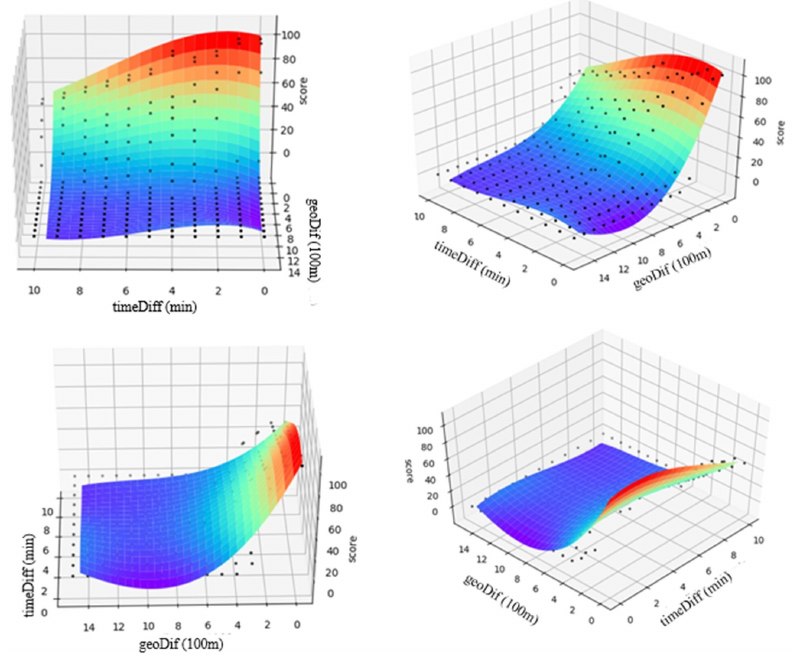
Figure 6. Visualization of affinity function of face–phone trajectory point pair.